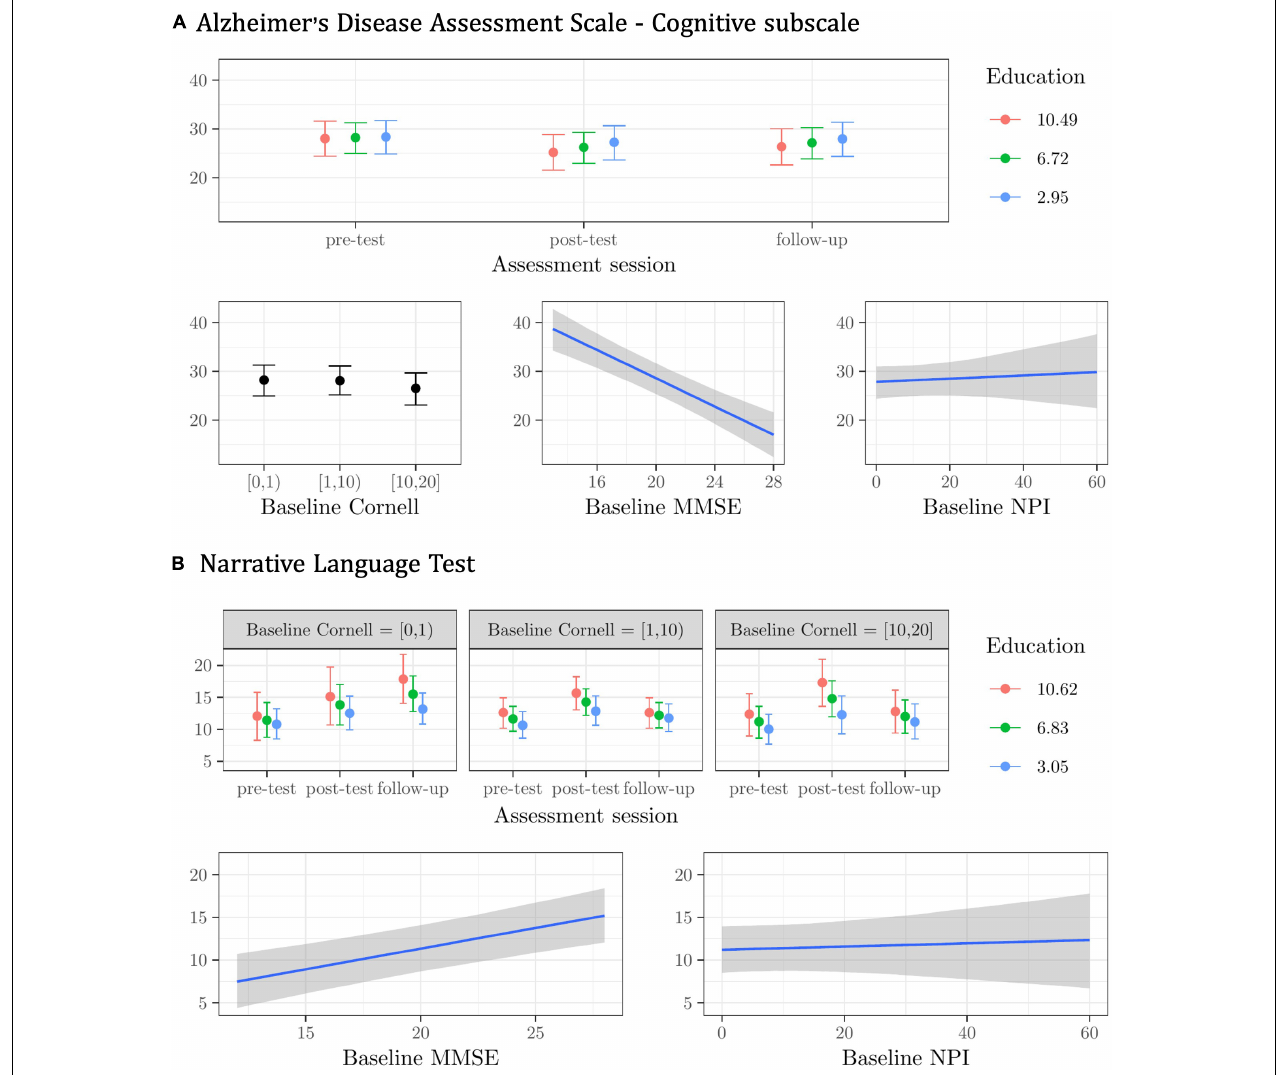
FIGURE 1 | Plots of the best model’s predictions for the primary outcome measures. (A) Alzheimer’s Disease Assessment Scale—Cognitive subscale (ADAS-Cog). (B) Narrative Language Test (NLT). For each measure, the plots represent the conditional effects of the predictors on the dependent